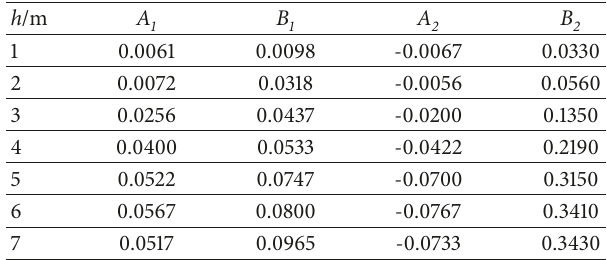
Table 5: Relationship between filling height and A